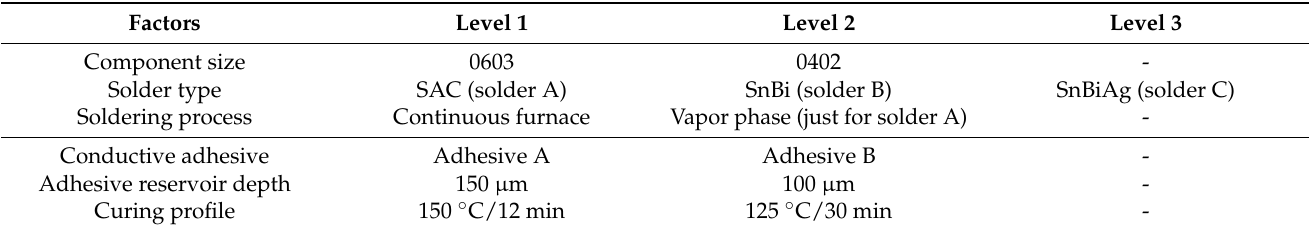
Table 1. Factors and levels for DoE of shear tests for soldering and conductive adhesive bonding. The factors and levels are evaluated in a full factorial manner, i.e., all factors are examined with all possible combinations.